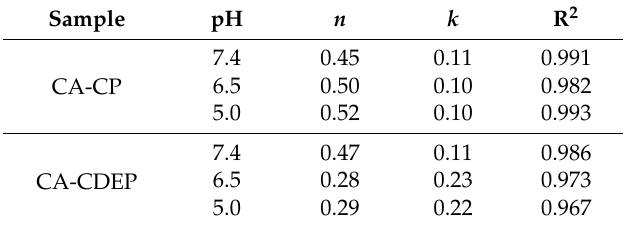
Table 3. Fitting parameters of PTX release data from PTX-loaded micelles at different pH. Sample